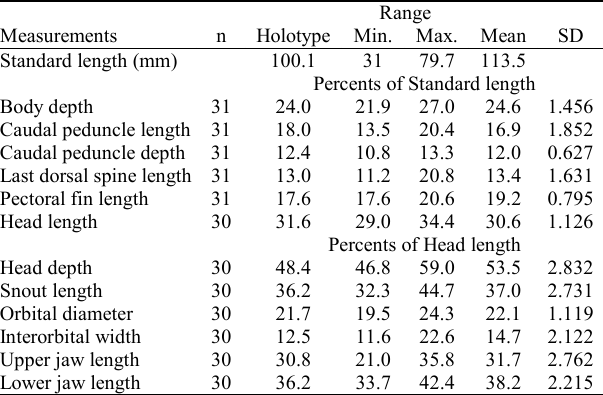
Table 2 . Frequency counts of meristic characters of Crenicichla hadrostigma . MCP 40959, *=Holotype. Dorsal fin spines